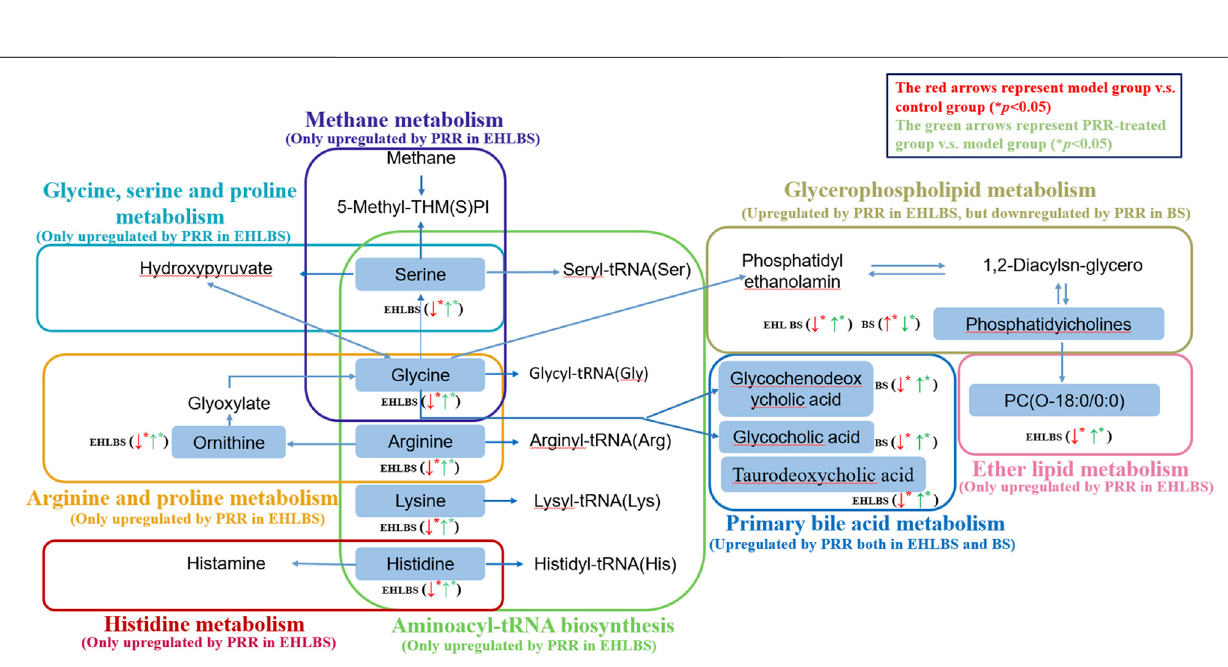
Frontiers in Pharmacology |